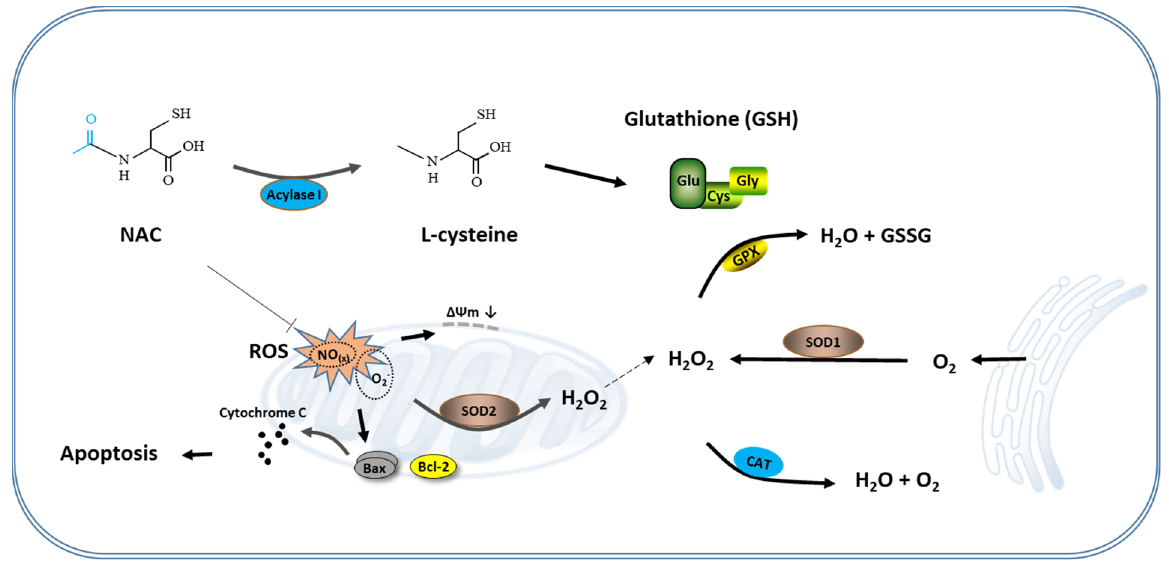
Figure 5. Schematic representation of the antioxidant mechanism of NAC. During the in vitro culture of the cumulus oocyte complex or IVF-derived embryos, excessive ROS produced in the cells lead to mitochondrial-mediated apoptosis. Supplementation of NAC to the culture medium eliminates these ROS and protects cumulus cells and blastomeres from apoptosis by prompting the synthesis of GSH and maintaining mitochondria function, thereby improving the developmental competence of oocytes and IVF-derived embryos. NAC, N-acetyl-L-cysteine.